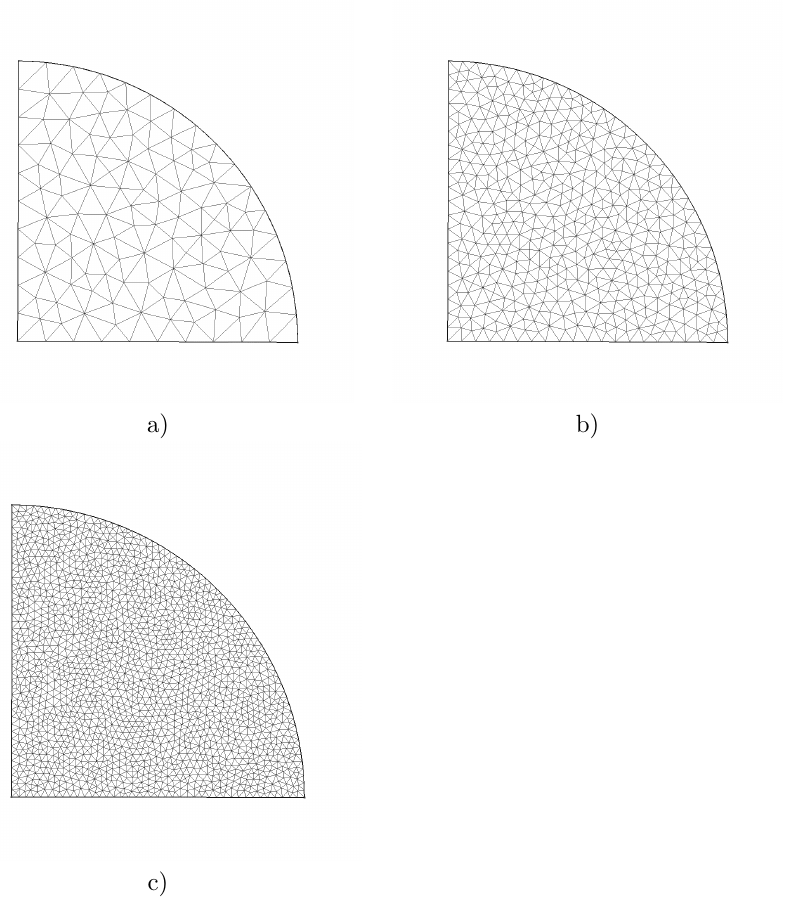
Figure 3. Grids: a) Grid 1: 123 vertices and 208 cells, b) Grid 2: 461 vertices and 848 cells, c) Grid 3: 1731 vertices and 3317 cells